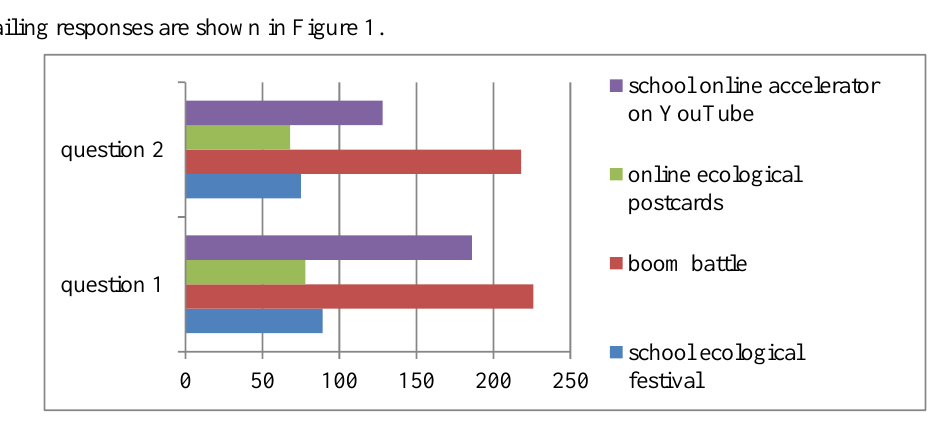
Figure 1. Participants ' responses on awareness of school events.